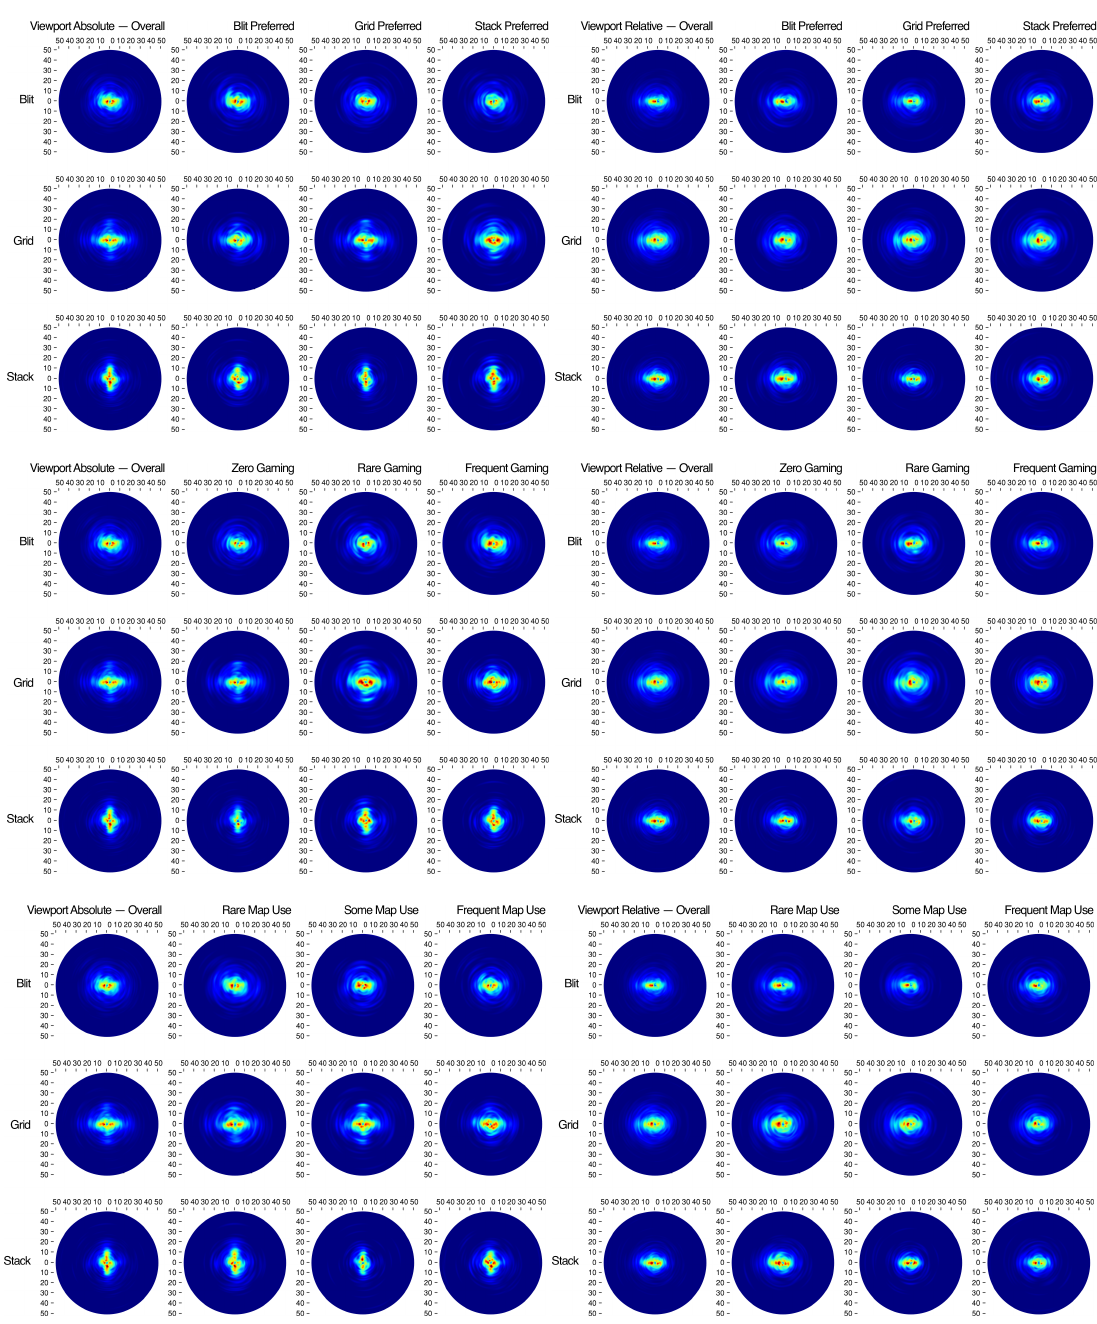
Figure A3. Polar plots showing the density probability distributions of absolute and relative saccades in the viewport—the eye movement component—in degrees, represented as polar plots, for each MCV system (blit/grid/stack) and subgrouped by the participants’ preference for an MCV system regarding its legibility ( top ), the frequency with which they play video games ( middle ), and the frequency with which they consult city maps ( bottom